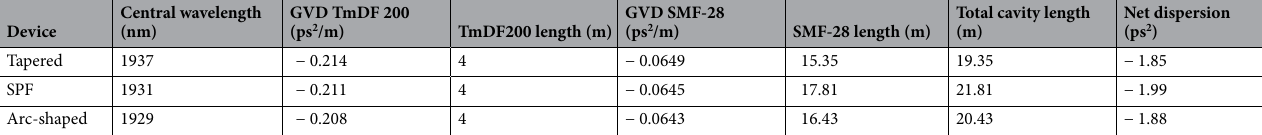
Table 2. The computed dispersion values for the TDFL cavities with different types of SA devices.